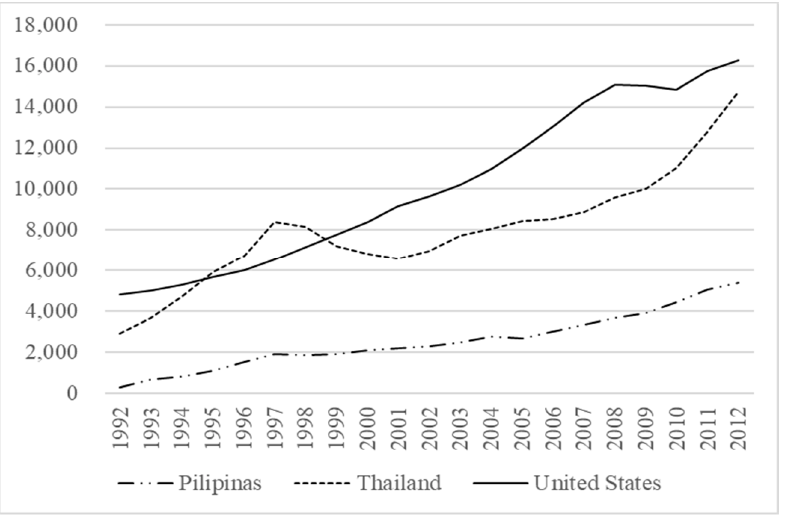
Figure 4. Domestic Loan (Unit: 1 Billion Domestic Currency), sourced by EIU country data.